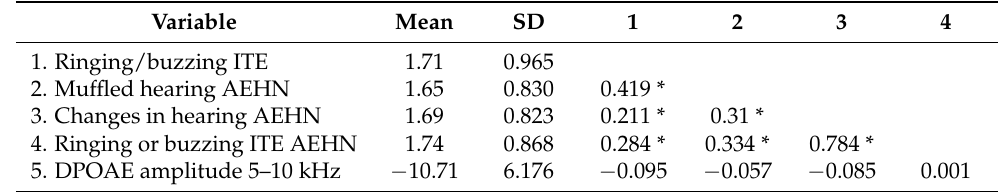
Table 1. Descriptive statistics and correlation coefficients for self-reported hearing symptoms and average DPOAE amplitude from 5 to 10